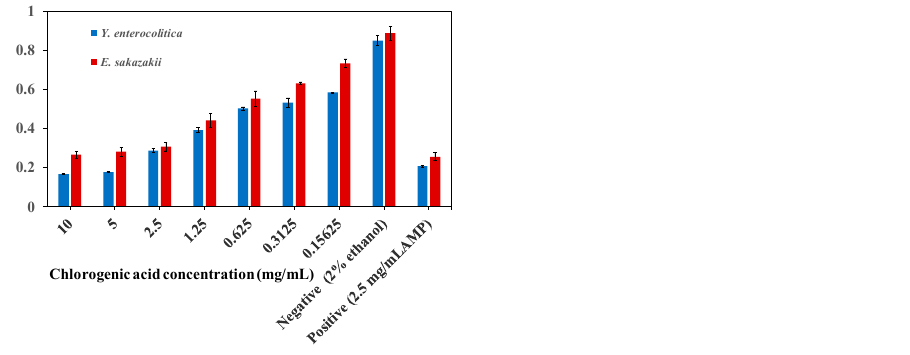
Figure 1. The OD 600 of Y. enterocolitica and E. sakazakii cells treated with different concentrations of CA at 8 h.